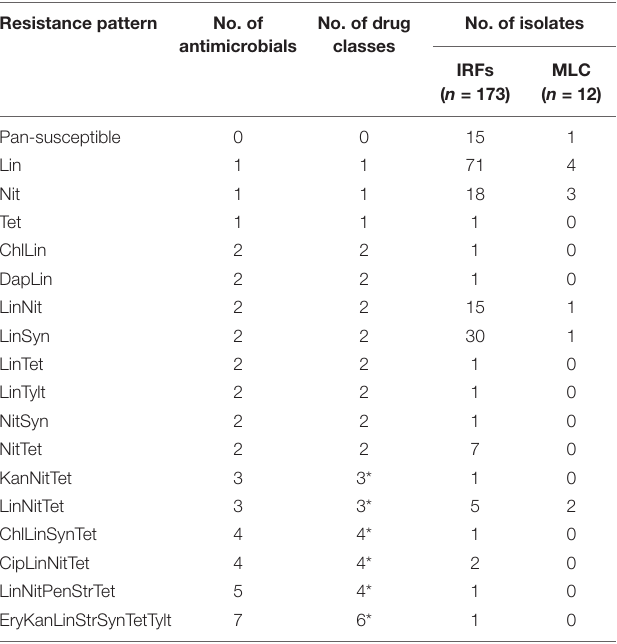
TABLE 8 | Single and multidrug resistance patterns in enterococcal isolates from the irrigation return flows (IRFs) and background canal site (MLC). Resistance